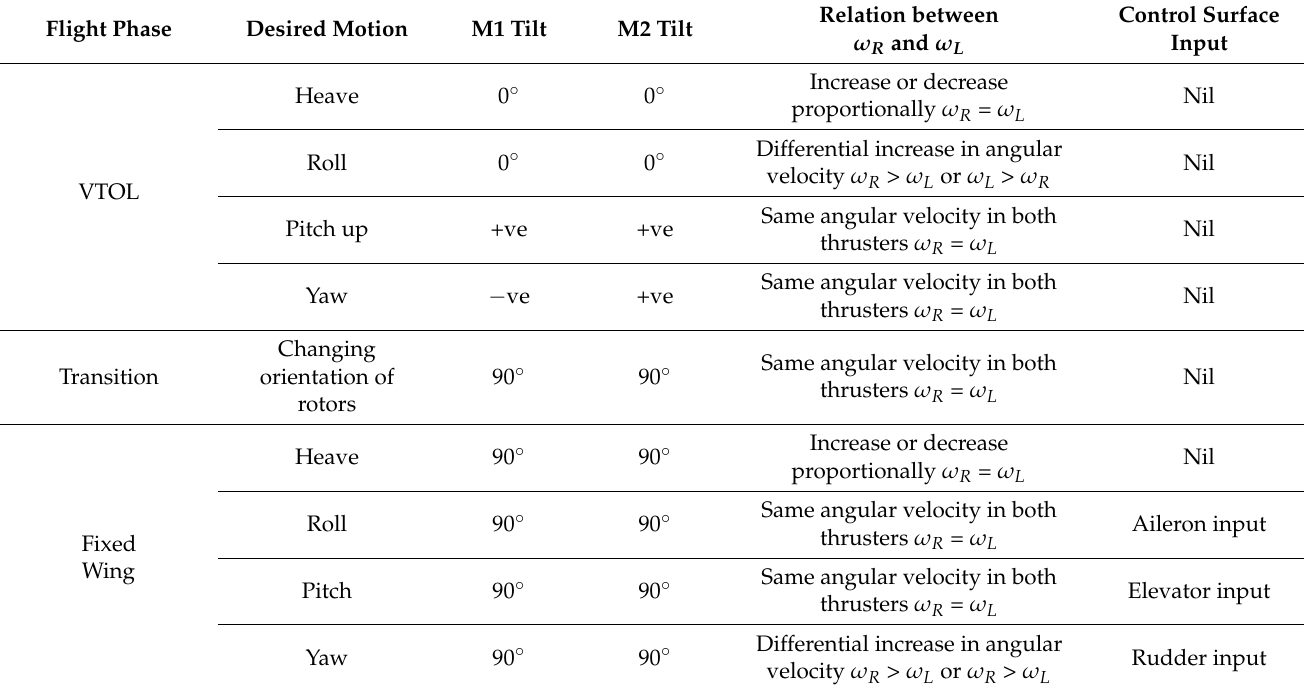
Table 2. Control inputs for various flight phases in hybrid VTOL